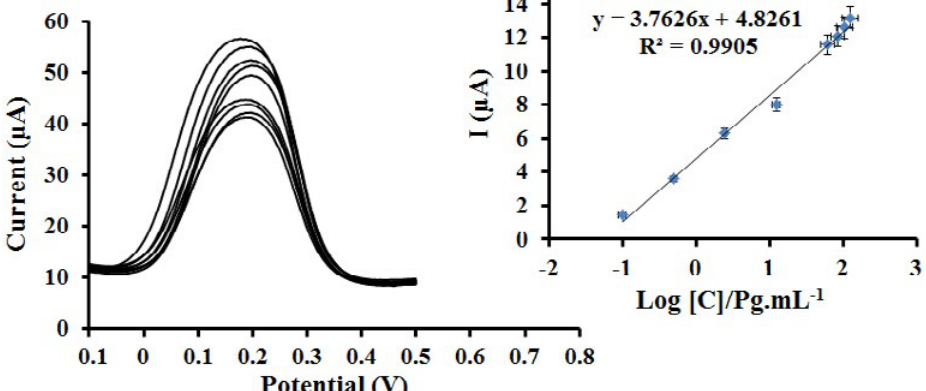
Fig. 3. (A) DPV responses of the immunosensor with increasing concentrations of HCG (from up to down: 0, 0.1, 0.5, 2.5, 12.5, 62.5, 85, 105 and 125 pg mL −1 ). (B) Calibration curve of the peak current response versus the logarithm of HCG concentration. The parameters Fig. 3 of DPV are as follows: initial potential, −0.1 V; final potential, −0.5 V; amplitude, 25 mV; modulation time of 50